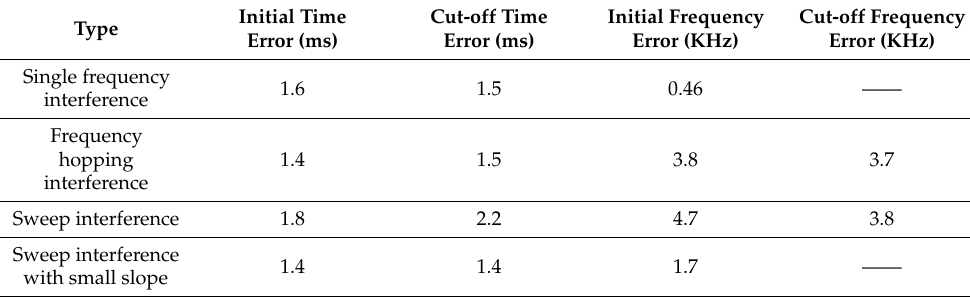
Table 3. Average absolute error of interference identification parameter